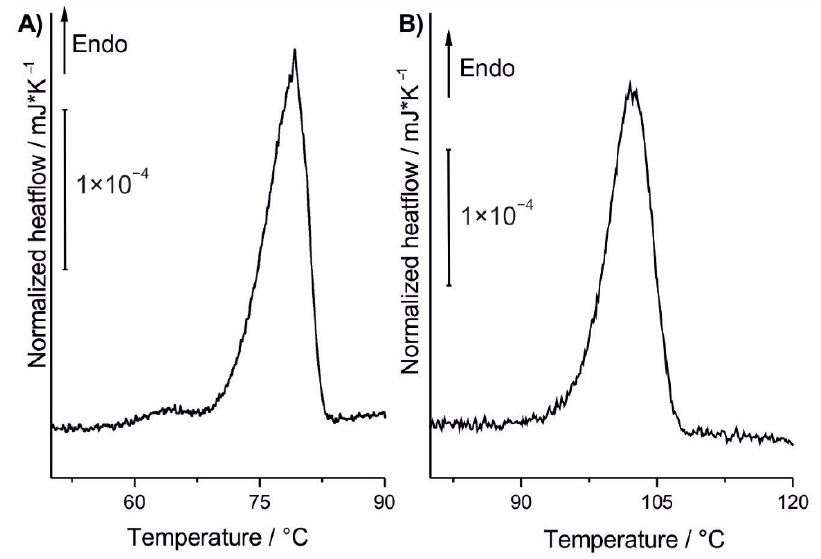
Figure 8. Heating scans of compound 4 ( A ) and compound 5 ( B ) crystallized from DMSO. 100 K/s heating